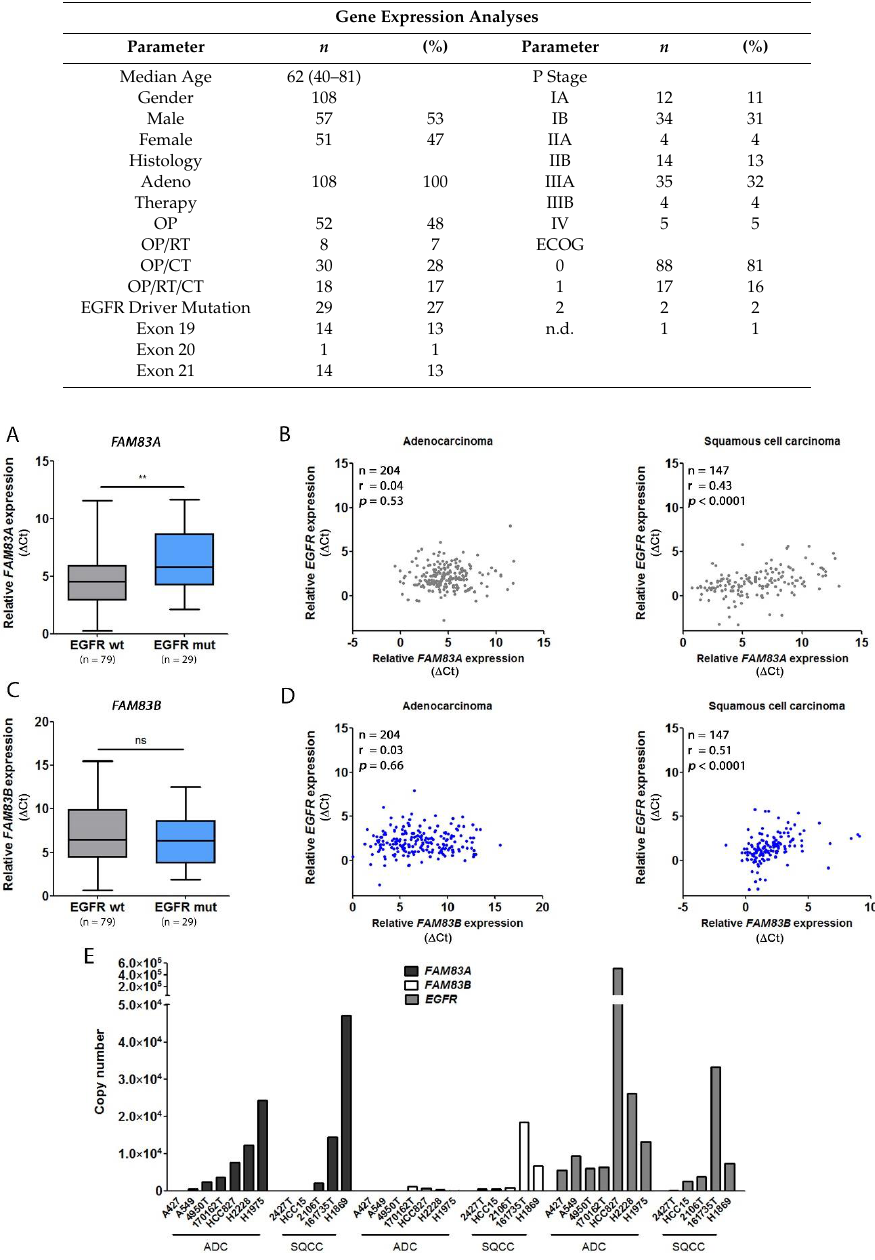
Figure 3. Relation between FAM83A and B expression and EGFR status and expression. ( A ) Relative expression of FAM83A in patients with wild-type EGFR and mutational variants normalized to the housekeeper genes ESD and RPS18 . As relative expression is depicted ( ∆C t ), lower values correspond to a higher expression. ( B ) Correlation plots between FAM83A and EGFR expression in the tumor tissue. ( C , D ) represent the respective results for FAM83B . ( E ) Absolute copy number of FAM83A , FAM83B , and EGFR in ADC and SQCC cell lines. The correlations were estimated using the Spearman’s rank correlation coe ffi cient. For statistical analysis, Mann–Whitney U test was performed (** p < 0.005, ns = not